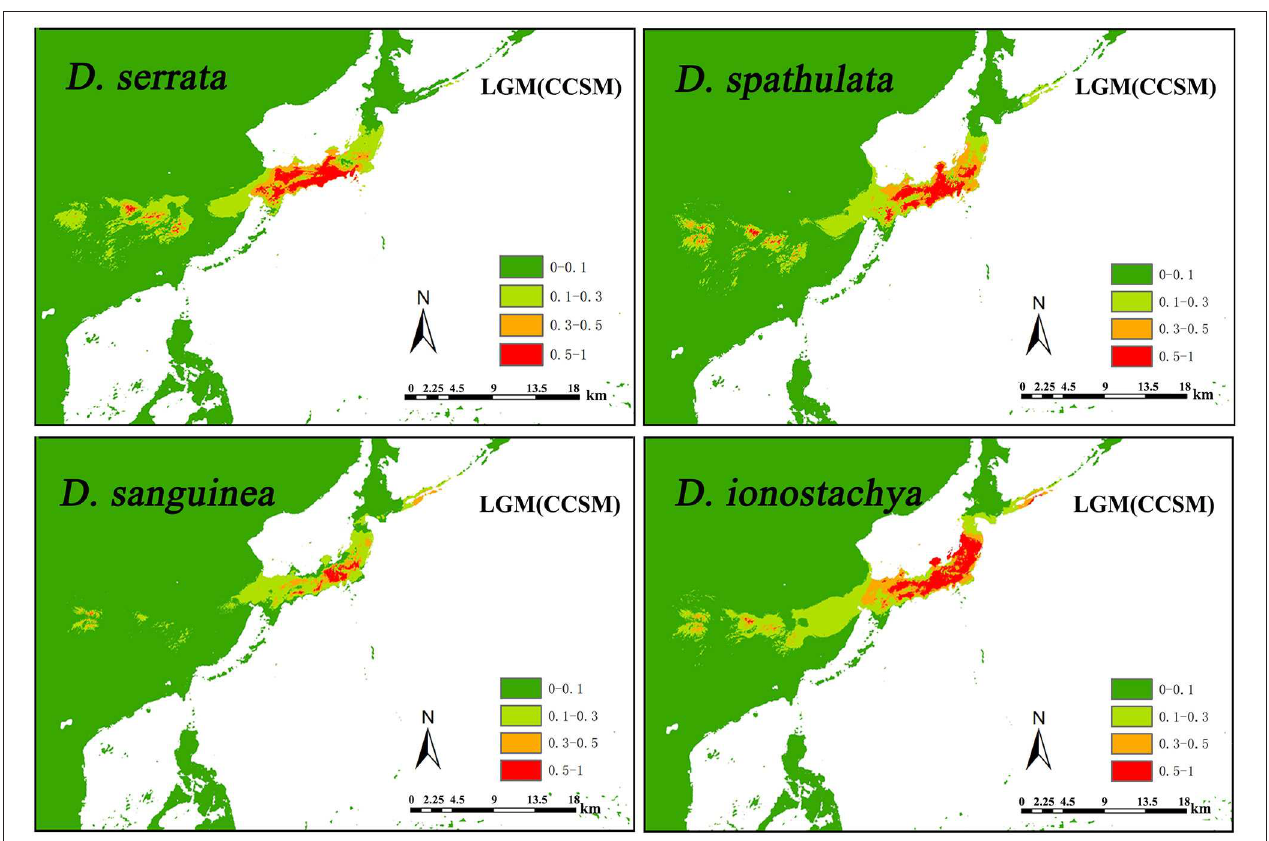
FIGURE 4 | Comparison of potential distributions as probability of occurrence for Diabelia serrata, D. spathulata, D. sanguinea, and D. ionostachya (Landrein and Farjon, 2019), at the CCSM climatic scenarios of the Last Glacial Maximum (LGM, ca. 21,000 years BP). The maximum training sensitivity plus specificity logistic threshold has been used to discriminate between suitable (cutline 0.1–1 area) and unsuitable habitat. The darker color indicates a higher probability of